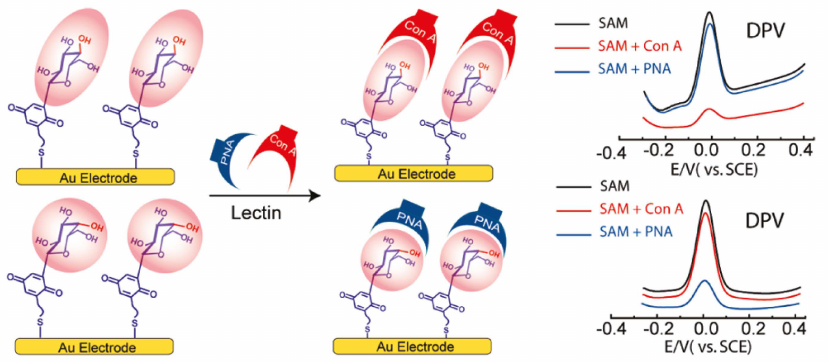
Figure 8. Epimeric monosaccharide-quinone hybrid monolayer-modified Au electrodes for lectin sensing. Reprinted with permission from Journal of the American Chemical Chemistry. Copyright 2011 American Chemical Society